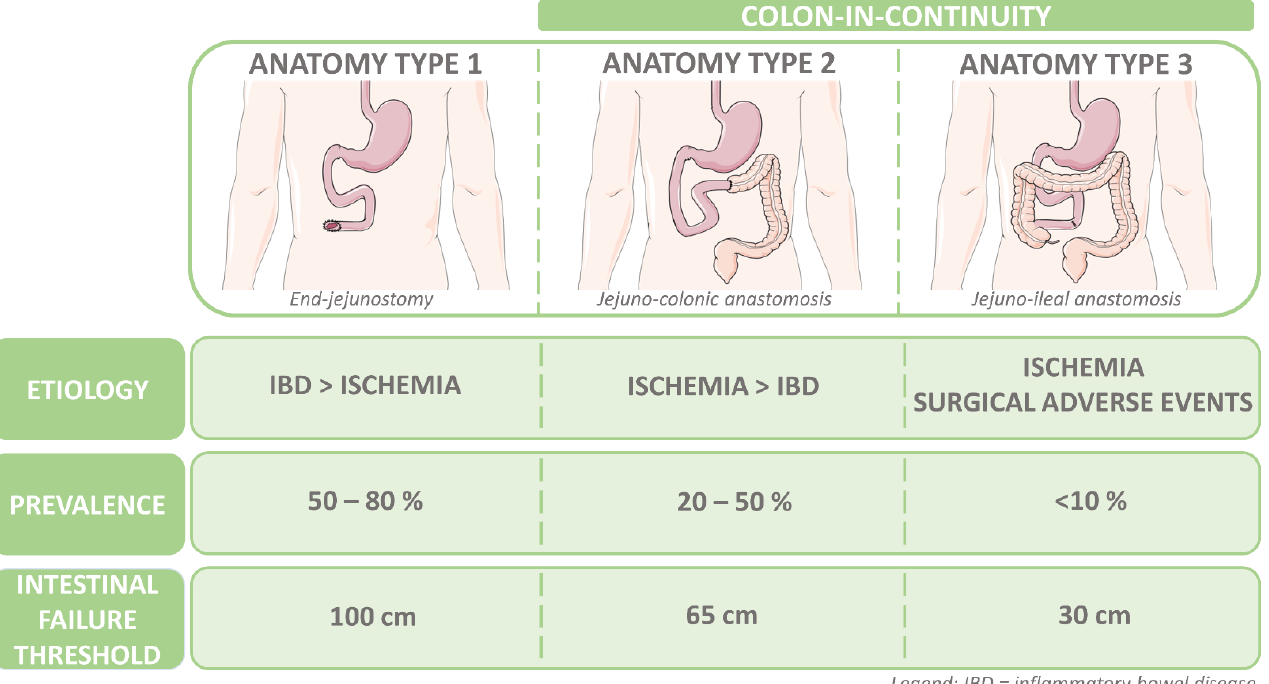
Figure 1. Short Bowel Syndrome Main Anatomy Types in relation to Etiology, Prevalence, and Intestinal Failure Threshold Length. Characterization based on region of intestinal resection. Intestinal failure threshold length relates to the remaining length of small intestine within the three main anatomy types. Adapted from Verbiest et al. [3].